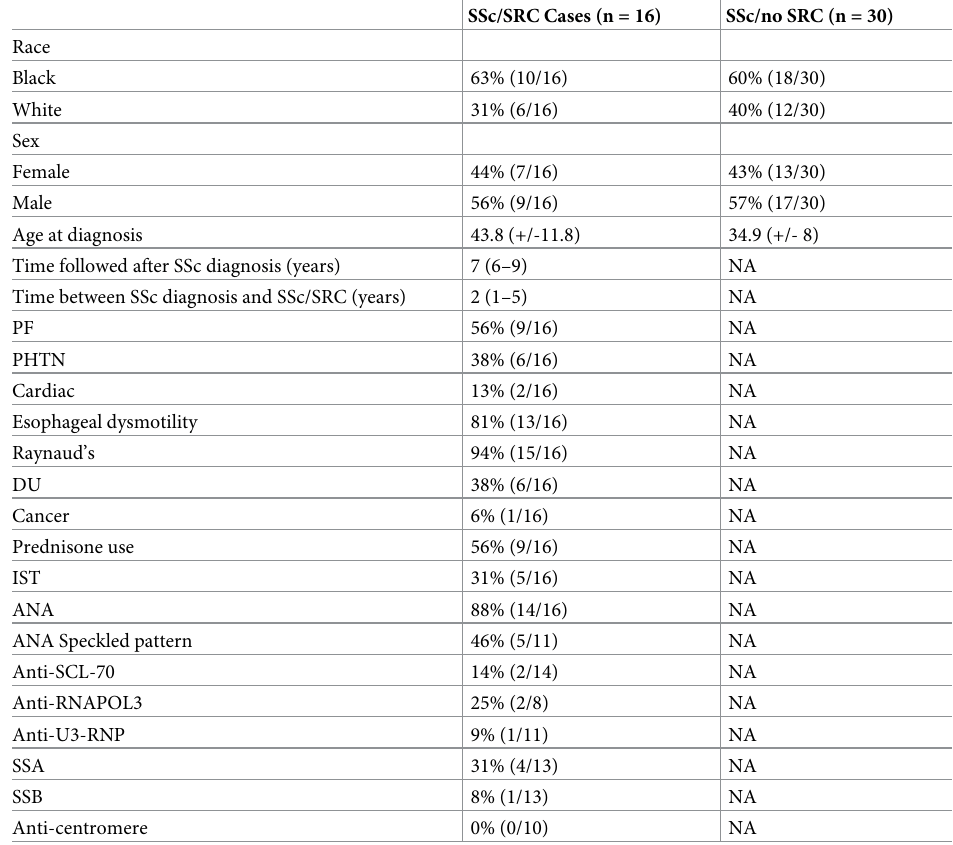
Table 1. Clinical characteristics of SSc cohort.